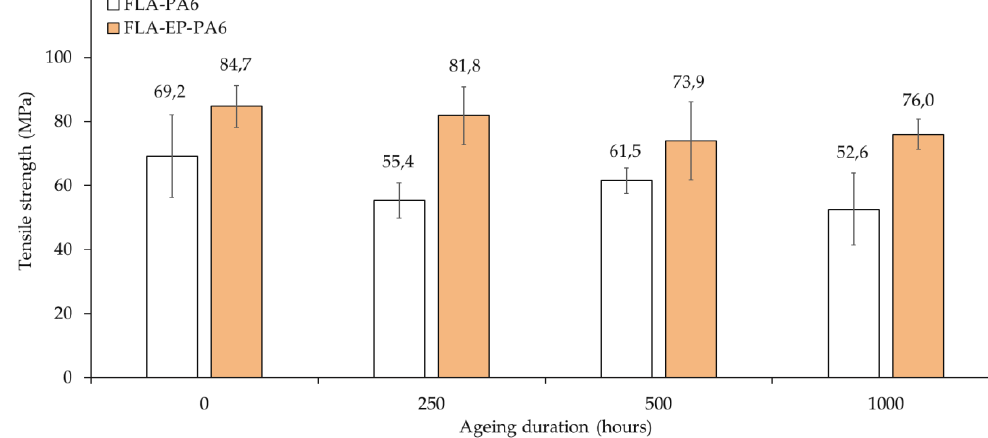
Figure 8. Tensile strength of the biocomposites under ageing conditions.